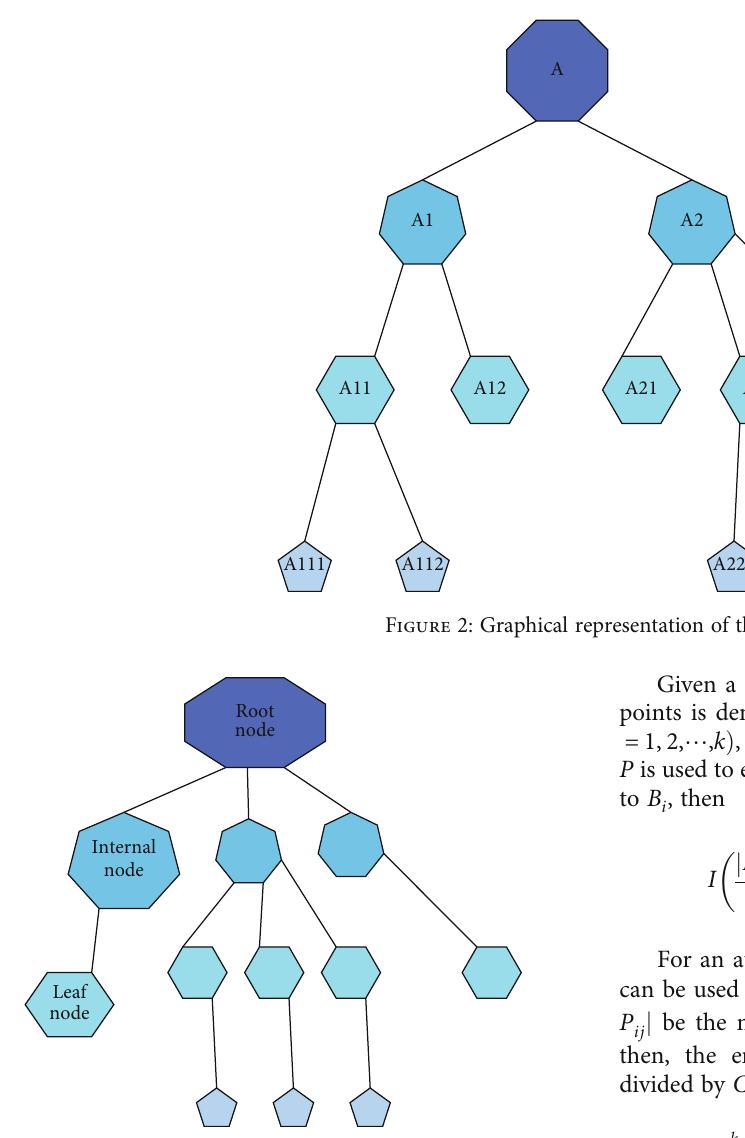
Figure 3: Graphical representation of a decision